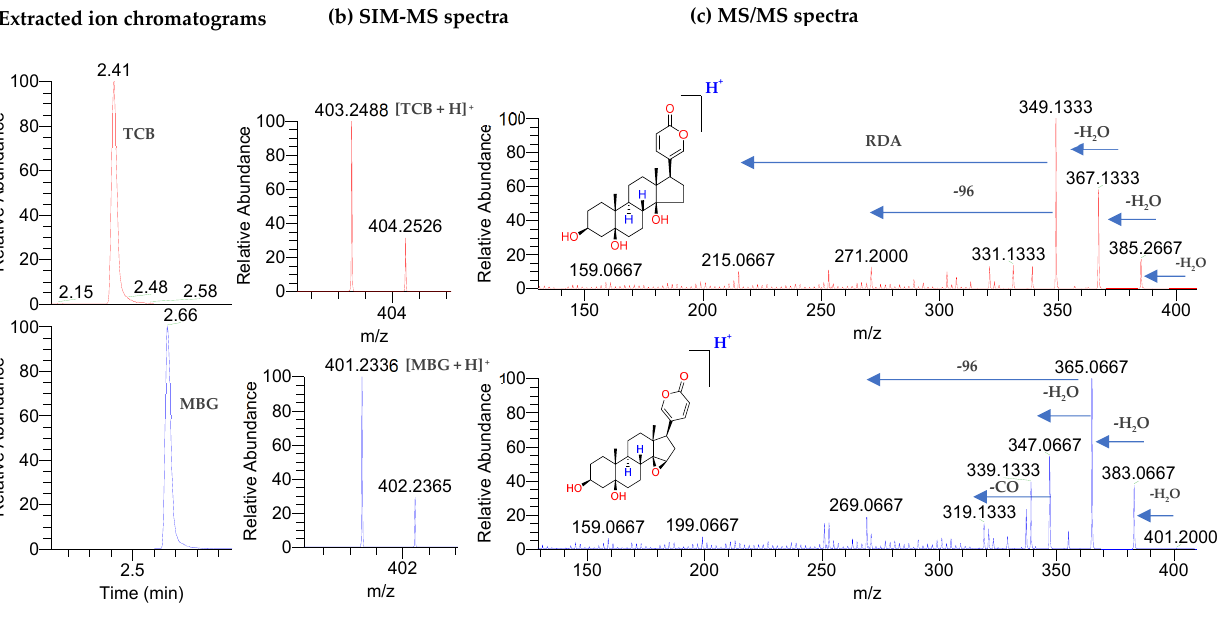
Figure 3. Analysis of CTS spiked in mobile phase by UHPLC-Orbitrap-MS and MS/MS: ( a ) EICs showing retention times of TCB and MBG; ( b ) SIM scan mass spectra, showing protonated TCB [M + H] + = m/z 403.2488, and MBG [M + H] + = 401.2336; ( c ) MS/MS spectra for the [M + H] + ions at m/z values of 403.2488 and 401.2336.